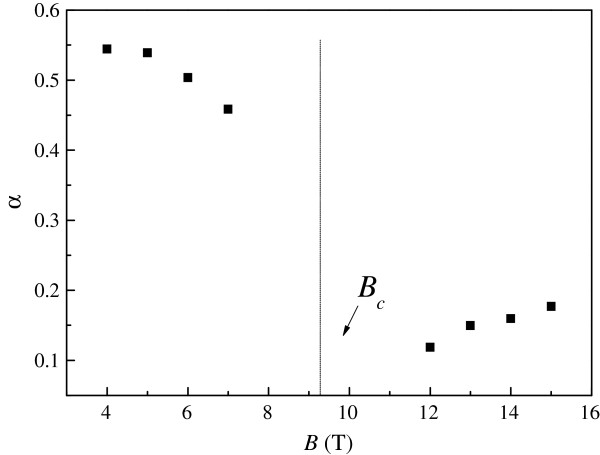
The determined exponent α in the power law TDF ∝ Iαversus magnetic field B.